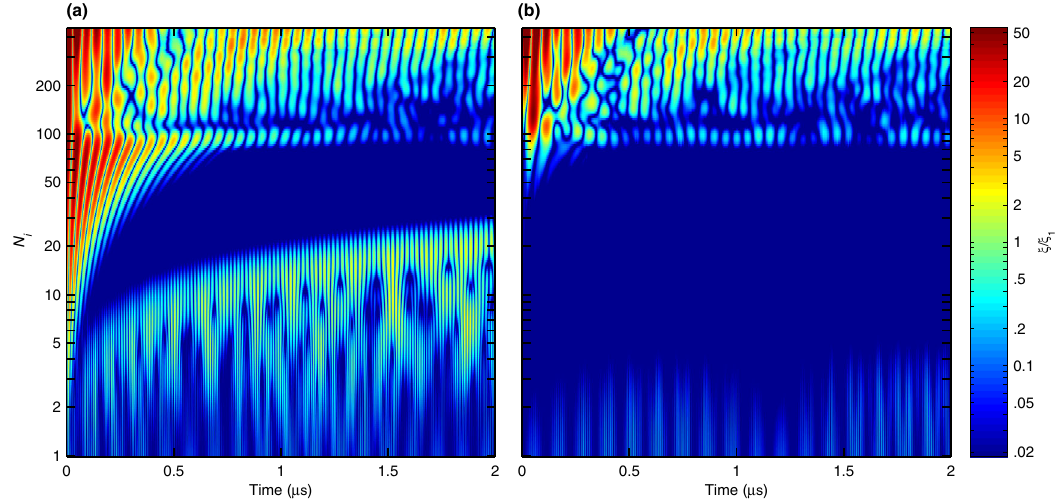
FIG. 1. Numerically simulated phase diagram. Quantum dynamics (without dissipation) of the homodyne signal in left (a) and right (b) cavities, as a function of total photon number (logarithmic vertical axis, with color bar normalized by ξ 1 , the homodyne signal of a coherent state with mean occupation of one photon), for the case where the system has been initialized into the Z ¼ 1 imbalance state, photons in a perfect coherent state, and both qubits initially in the ground state. The parameters chosen are as given in the text corresponding to the actual device used in the experiment. For photon numbers below the quantum renormalized critical number N qu c , tunneling is dynamically suppressed and we observe collapse-revival oscillations with ffiffiffiffi p ¼ N =g , as expected for decoupled single-site Jaynes-Cummings physics [23]. At very small photon period scaling as t r numbers, we see an “ exiguous ” regime where tunneling reappears. We also observe in this localized regime secondary revivals at long times (also present in the unitary evolution of the single-site Jaynes-Cummings model), which would be washed out in the presence of dissipation. The dynamics above the critical photon number displays Josephson-like oscillations with period ¼ ð 2 J Þ − 1 , becoming more linear with increasing photon number. We note that the critical number is marked by the coincidence t J ¼ t of two time scales, t . As the initial N increases, the revival period grows and ultimately matches that of the Josephson r J oscillation time scale, yielding the critical photon number N qu c ≈ g 2 = 4 J 2 ≈ 2 N cl , consistent with where the transition is observed in c the simulation. Solving the dynamics at the upper limit shown necessitates the solution of the time-dependent Schrödinger equation in a Hilbert space exceeding a dimension of size 10 6 . More details regarding the difficulty of such simulations can be found in the Supplemental Material